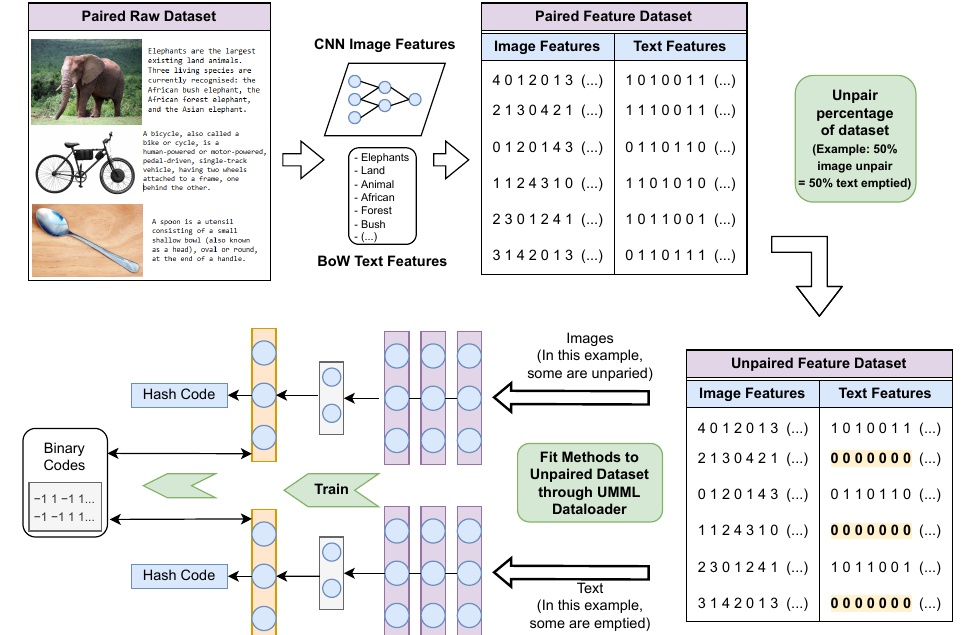
Figure 4. Unpaired Multi-Modal Learning (UMML) framework workflow. The diagram shows an example of 50% of images being unpaired where 50% text Bag of Words (BoW) binary vectors are emptied. Similarly, in the case of text being unpaired, the image feature matrices would be emptied (CNN: convolutional neural